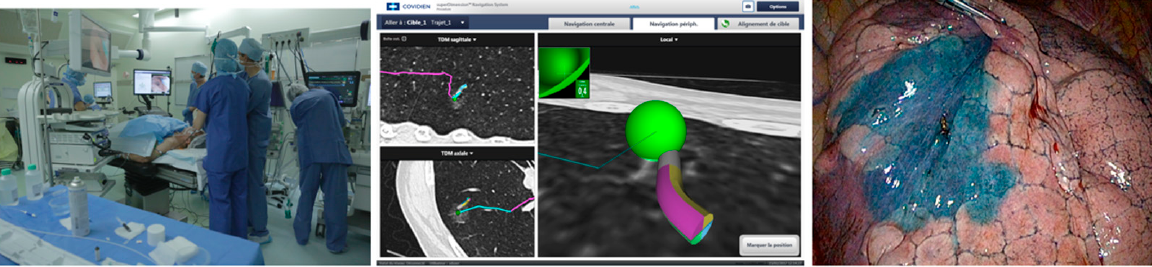
Figure 2. Dye marking using ENB, courtesy of Dr. Agathe Seguin-Givelet.